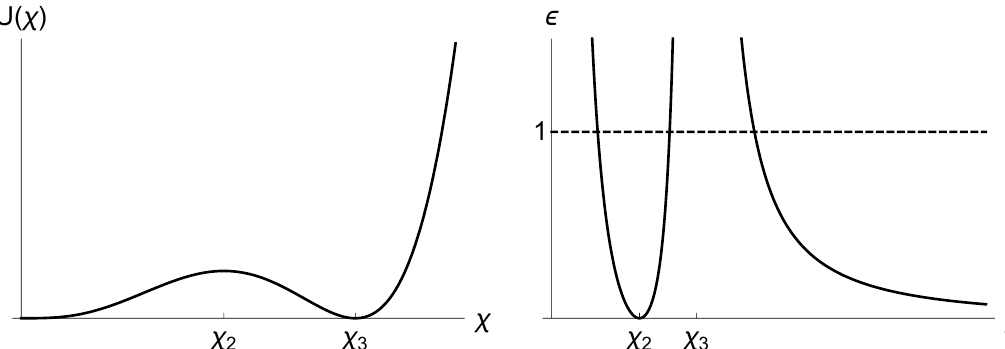
Figure 1. Reference plot for U ( χ ) (left) and for (cid:15) (right) in function of χ